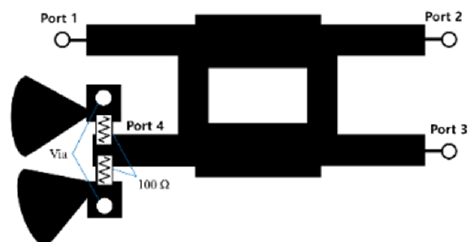
Figure 10. Configuration of the circular polarizer using a Branch-line coupler.